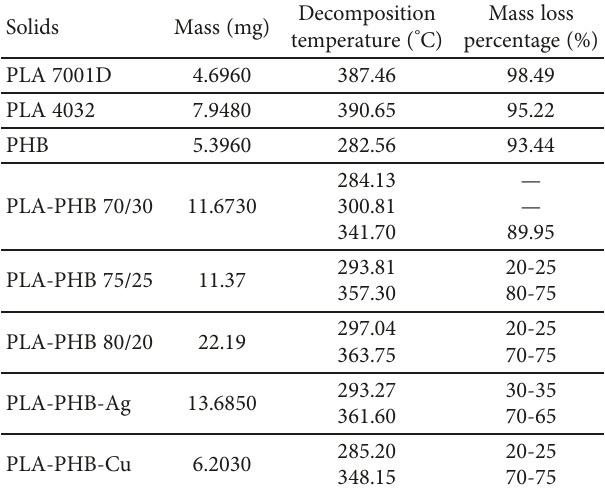
Table 4: Results obtained from the TGA tests.